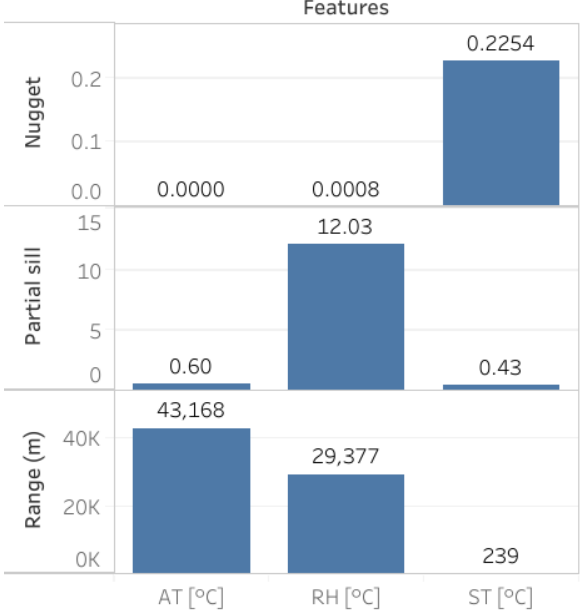
Figure 6. Optimized semivariogram parameters.